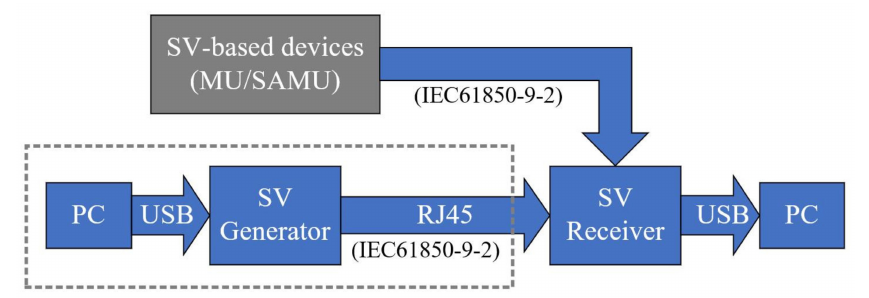
Figure 5. Emulation scheme of the SV-based